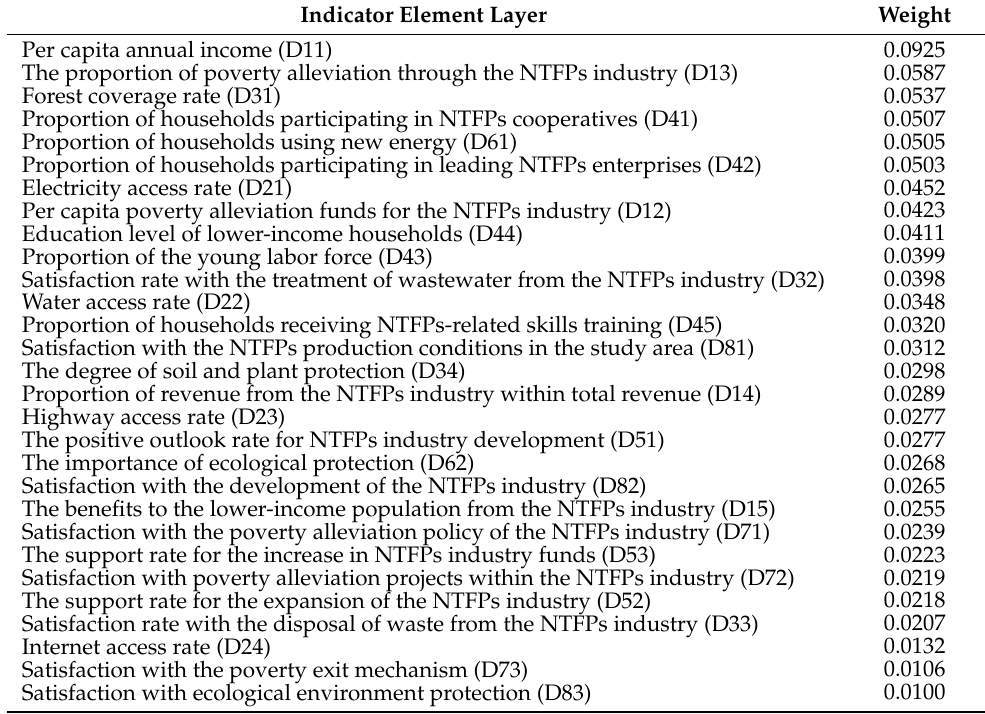
Table 12. The ranking of each indicator weight at the indicator element level. Indicator Element Layer Weight Per capita annual income